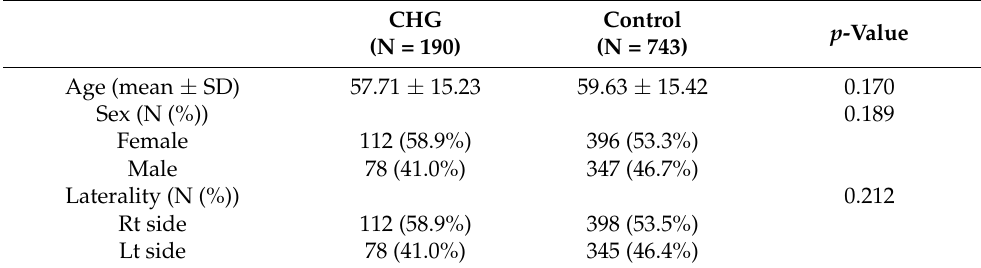
Table 2. The characteristics of primary THA